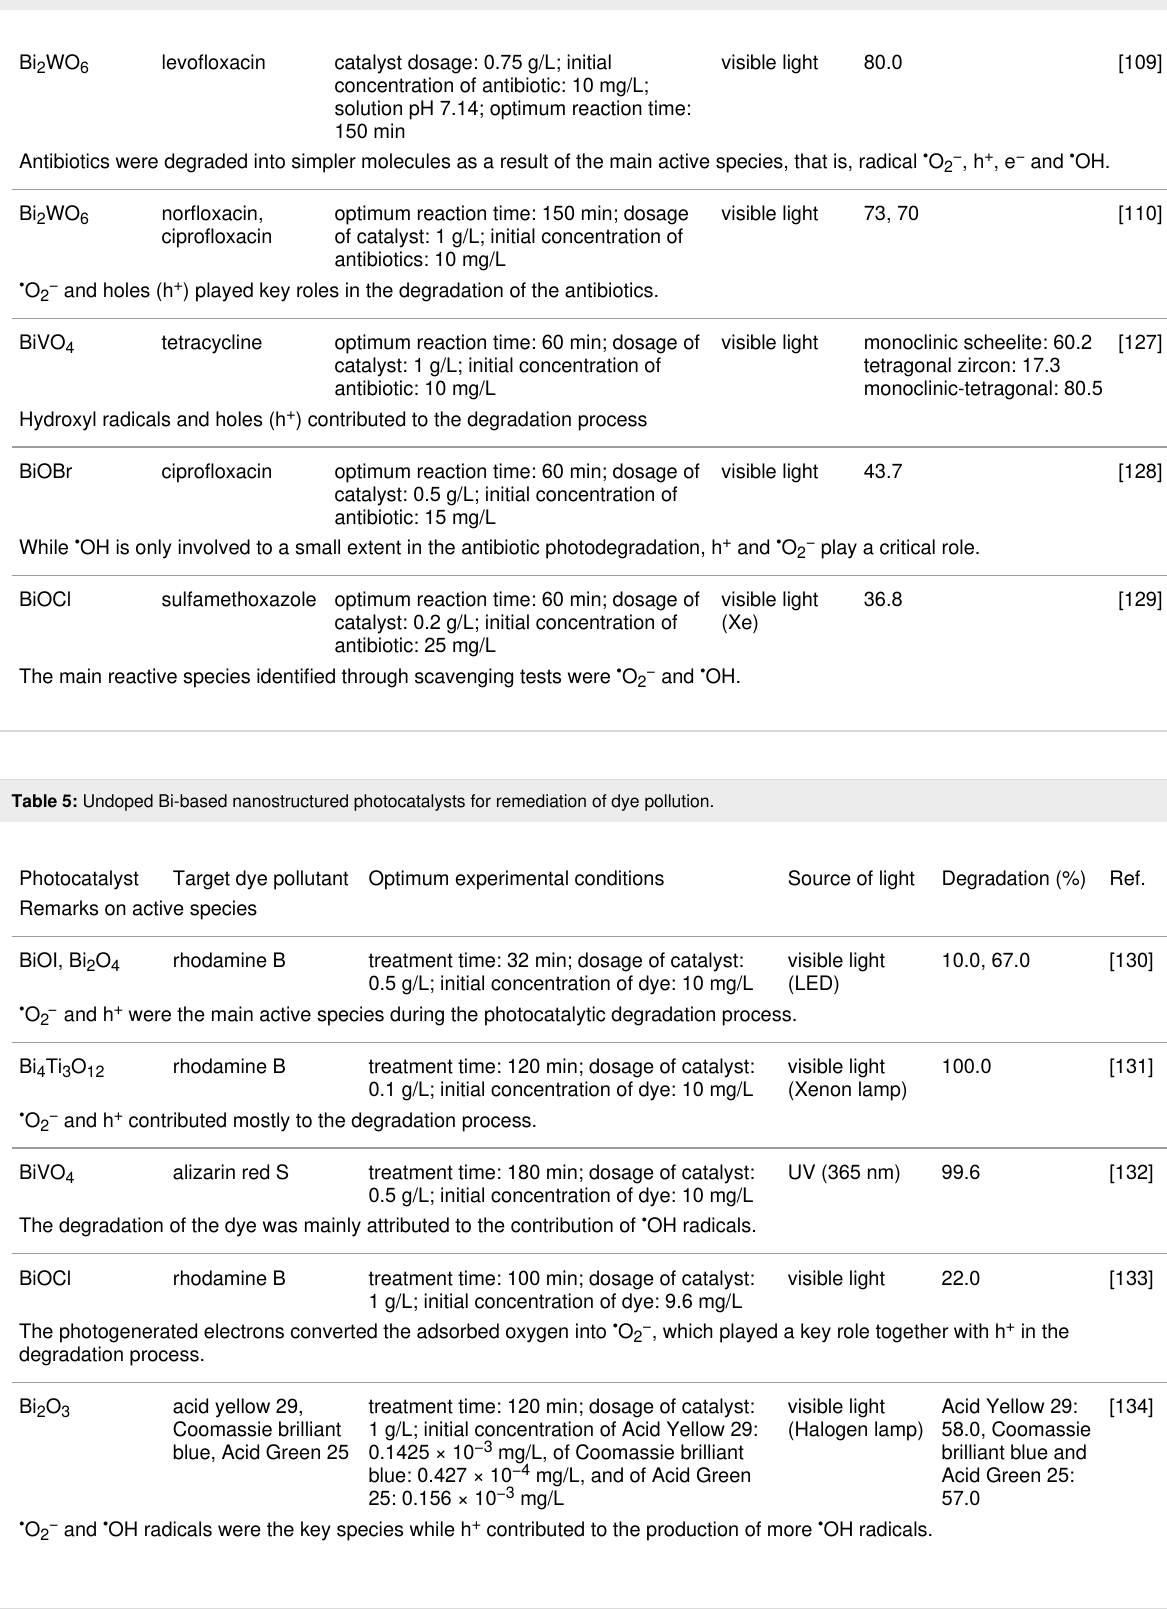
Table 4: Undoped Bi-based nanostructured photocatalysts for antibiotic remediation. (continued)